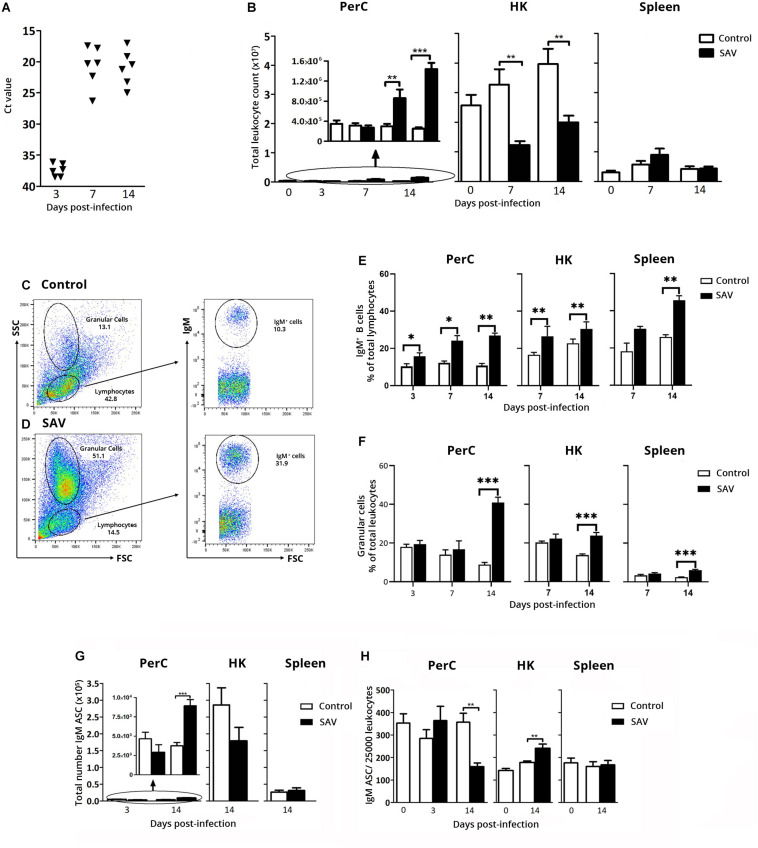
Early PerC response to IP SAV3 infection in Atlantic salmon involves IgM+ B cells and IgM ASC. (A) RNA levels of SAV3 nsP1 in serum samples, presented as Ct values. (B) Total leukocyte count in PerC, HK, and spleen. Representative flow cytometry cytograms showing the gating of IgM+ B cells, and granular cells in the PerC of (C) control and (D) SAV3 infected fish. Flow cytometry analysis of IgM+ B cells presented as (E) frequency of total lymphocytes and (F) Percentage granular cells of total leukocytes. IgM ASC analyzed by ELISpot in the PerC, HK, and spleen from control and SAV3 infected fish presented as (G) total IgM ASC per site or (H) IgM ASC frequency per 25,000 leukocytes. Statistical significance between control and SAV3 groups are indicated by brackets. Asterisks indicate strength of significance: **p < 0.01 and ***p < 0.001. For all analysis, data present mean + SEM from at least six individuals (n ≥ 5).